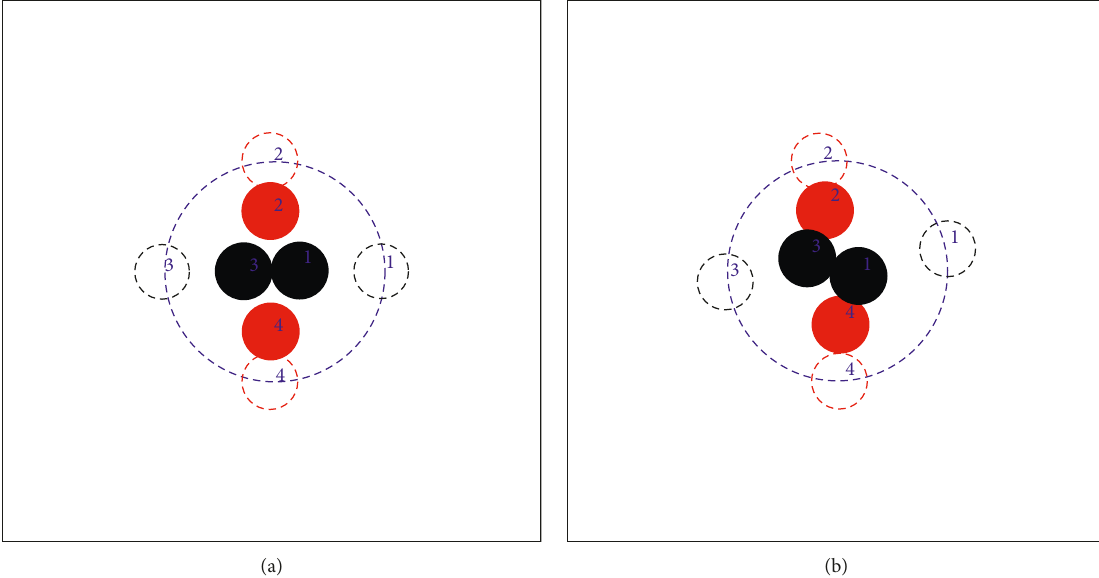
Figure 7: The initial position of two negative and two positive DEP particles are initially equispaced on a circle in a uniform DC electric field with E 1 kV/m along x direction, and the final particle chains after DEP interaction under different status: (a) θ 0 (cid:31)